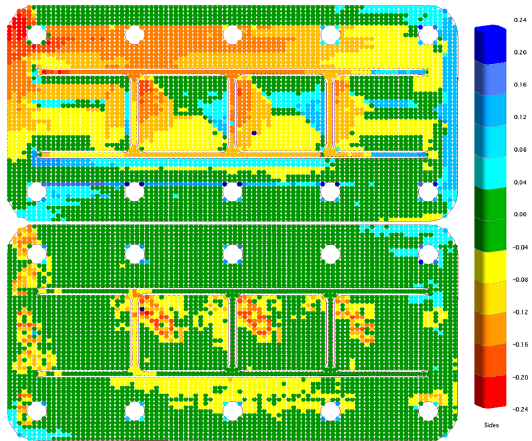
Figure 27. Comparison of measured main plane vs. nominal CAD. ( top ) without feedback; ( bottom ) with feedback.